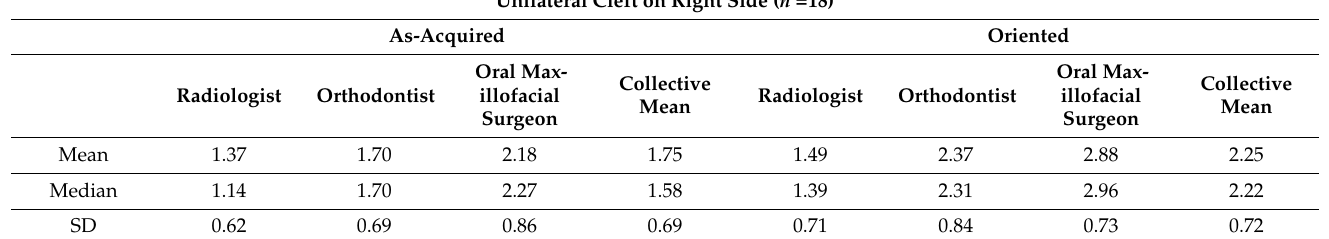
Table 3. Mean bone volume for unilateral cleft on left and right side.